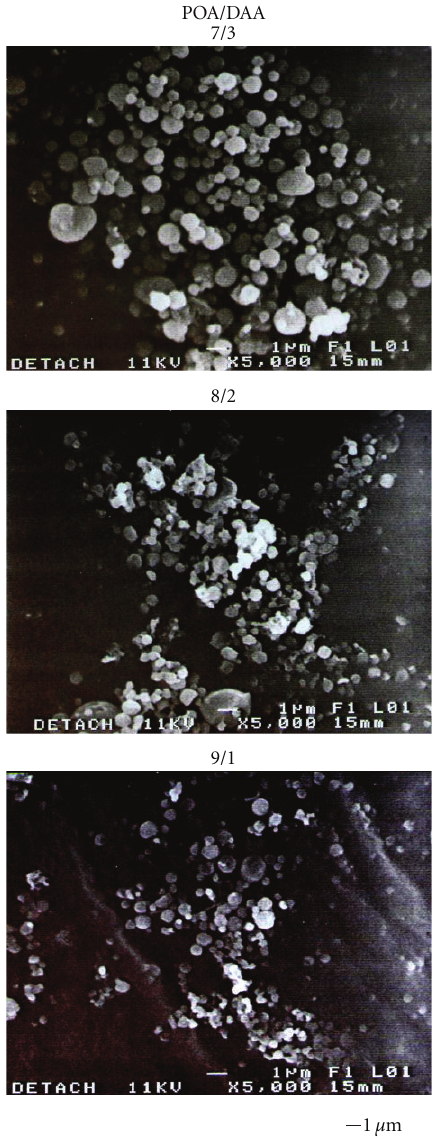
Figure 15: SEM images of the nanospheres obtained from the copolymers with POA/DAA of 7/3, 8/2, and 9/1. PA/DAA = 0.5, heterogeneous state.